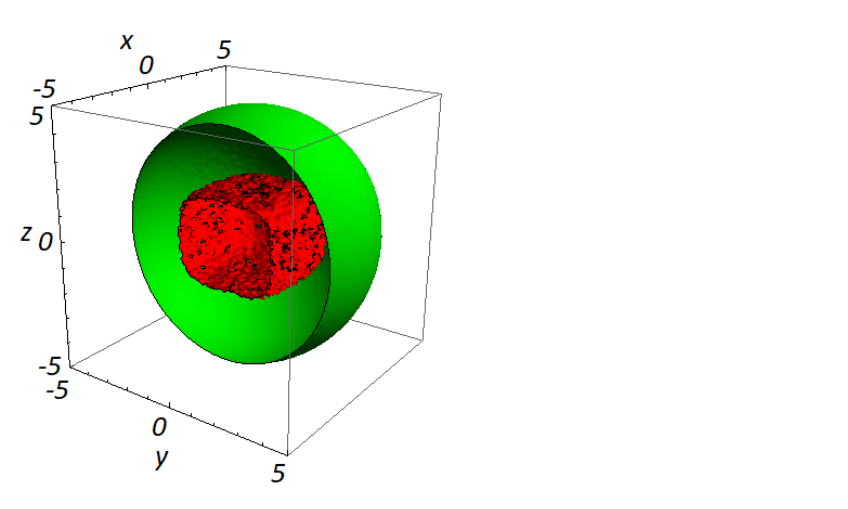
Figure 12. The reconstruction of the surface of the cubic scatterer with semi-edges 2, units in cartesian coordinates. To reveal transparently the structure of the inversion, the region x > − 1.8 has been